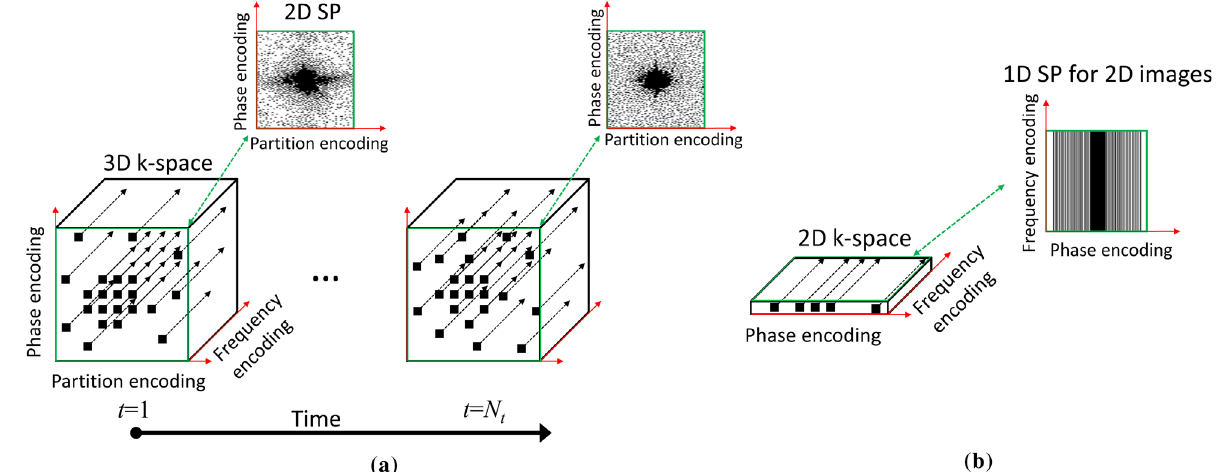
Figure 1. Illustration of the ( a ) 3D + time data collection scheme considered in this work. The sampling pattern is in 2D + time, it comprises the time-varying phase and partition encoding positions, for each of which data are to be collected by the MRI scanner for all frequency encoding positions. Our method can also be applied to ( b ) 2D data collection with fully-sampled lines in the frequency-encoding direction and a 1D sampling pattern denoting phase encoding